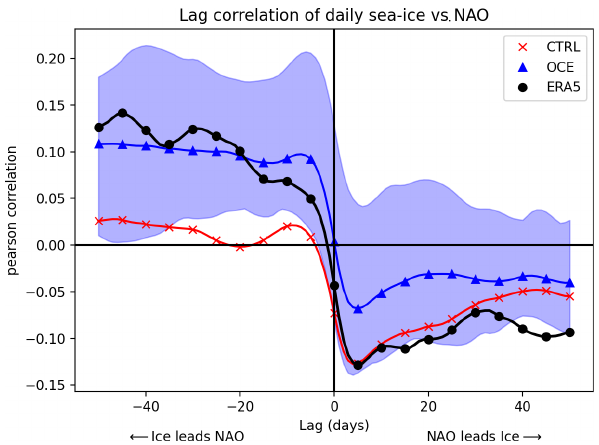
Figure 8. Lagged correlations of the daily NAO against the daily BKS sea ice for ERA5 (black dots), CTRL (red crosses), and OCE (blue triangles). Negative lags correspond to sea ice forcing the NAO, and vice versa for positive lags. Correlations are computed using all days in November through February, 1980–2015. Shad- ing indicates the ensemble spread of OCE: the CTRL spread (not shown) is similar in extent. Note that only every fifth point has been marked by a symbol for visual